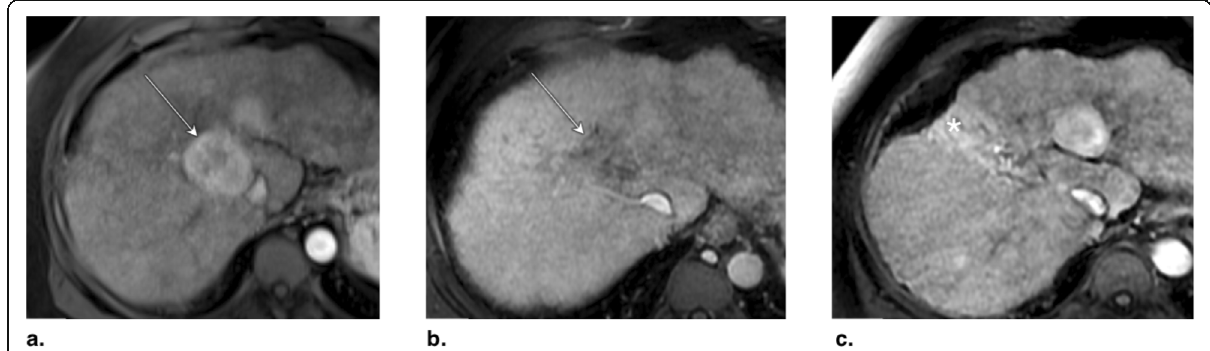
Fig. 32 Axial T1-weighted MR obtained ( a ) pretreatment: image in late arterial phase (AP) shows a 5-cm LR-5 observation (arrow). b 1 month post transarterial radioembolization (TARE): image in portal venous phase shows hypoenhancing area. c 1 year post TARE: image in late AP shows expected capsular retraction and perfusional anomalies (asterisk). The treated observation is categorized LR-TR